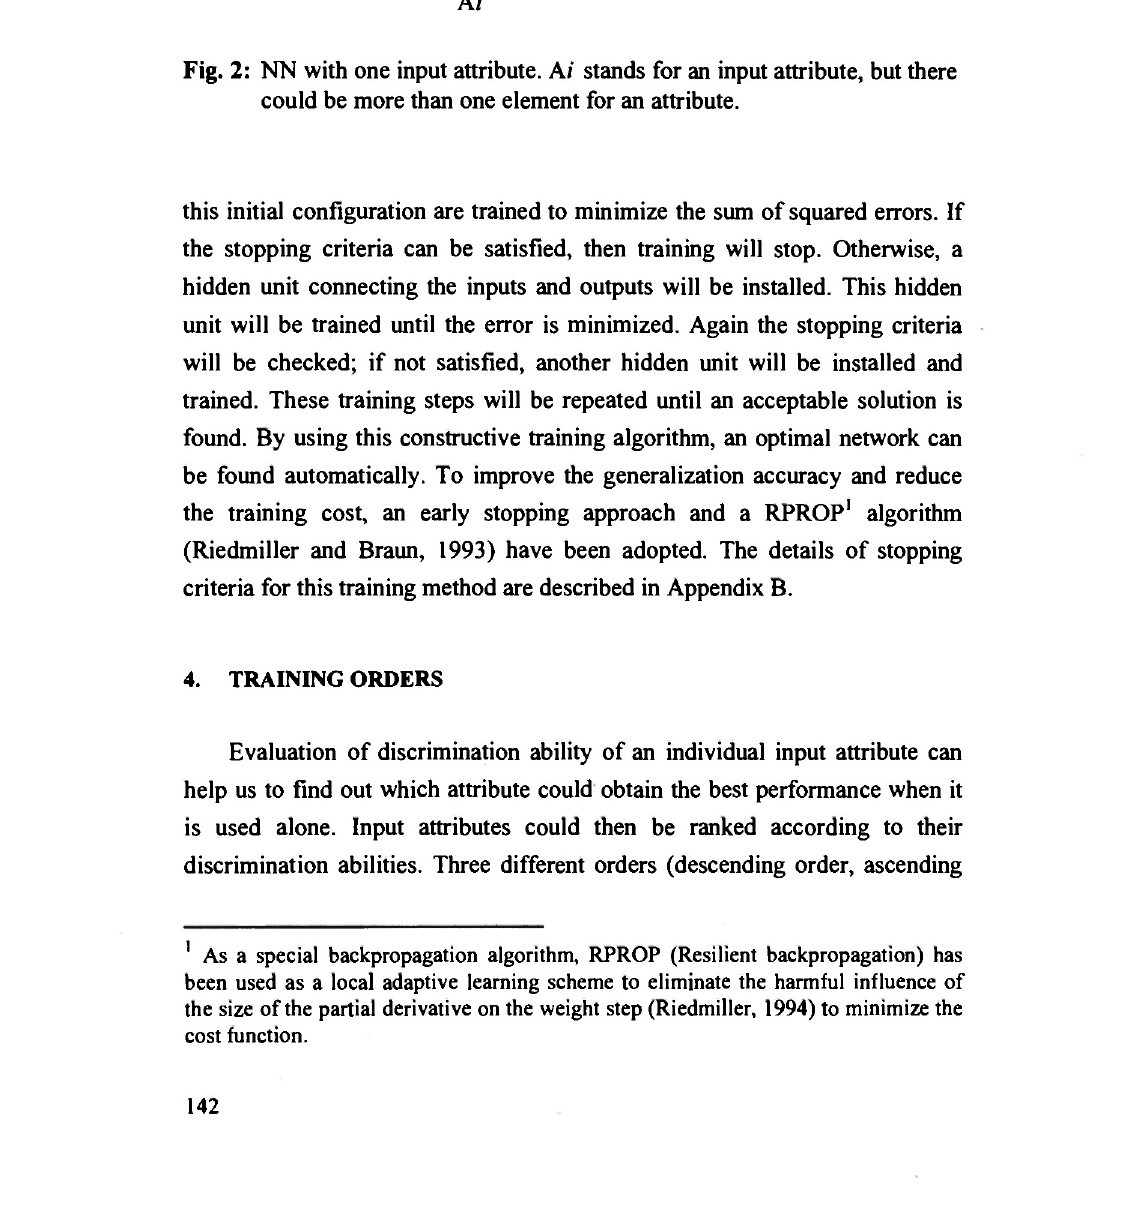
Fig. 2: NN with one input attribute. A/ stands for an input attribute, but there could be more than one element for an